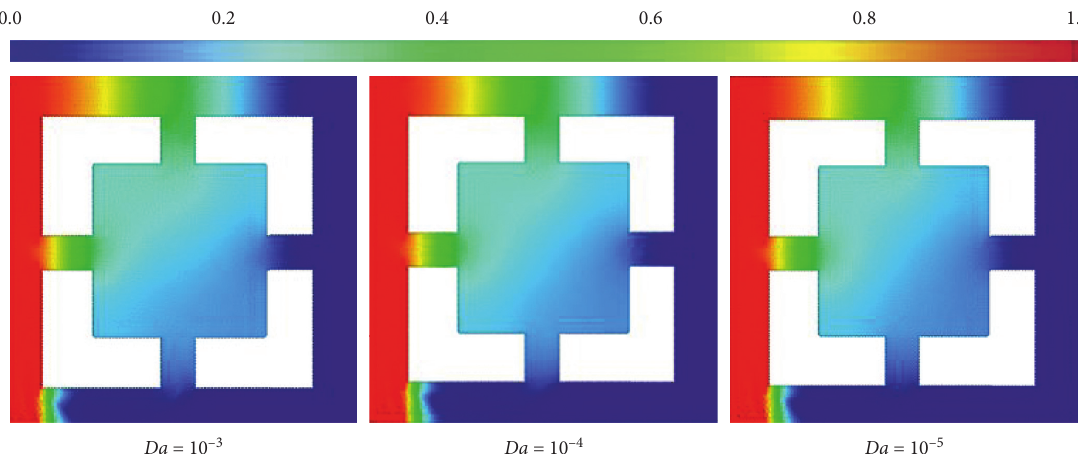
Figure 7: Features of concentration below the variations of a Darcy parameter at N � 1 , Ra � 10 4 , ϕ � 0 . 01, η and τ � 1.